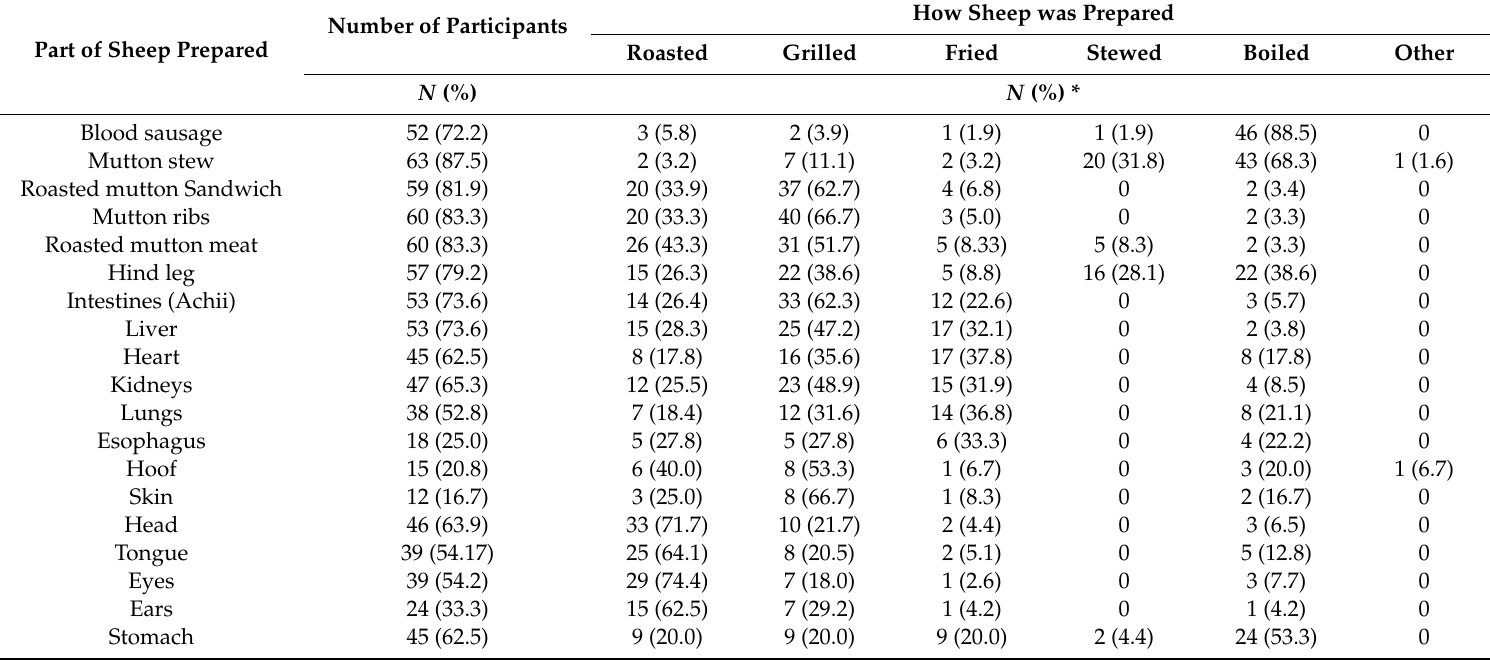
Table 4. Preparation of mutton among participants who completed the sheep survey, 2017 ( n =